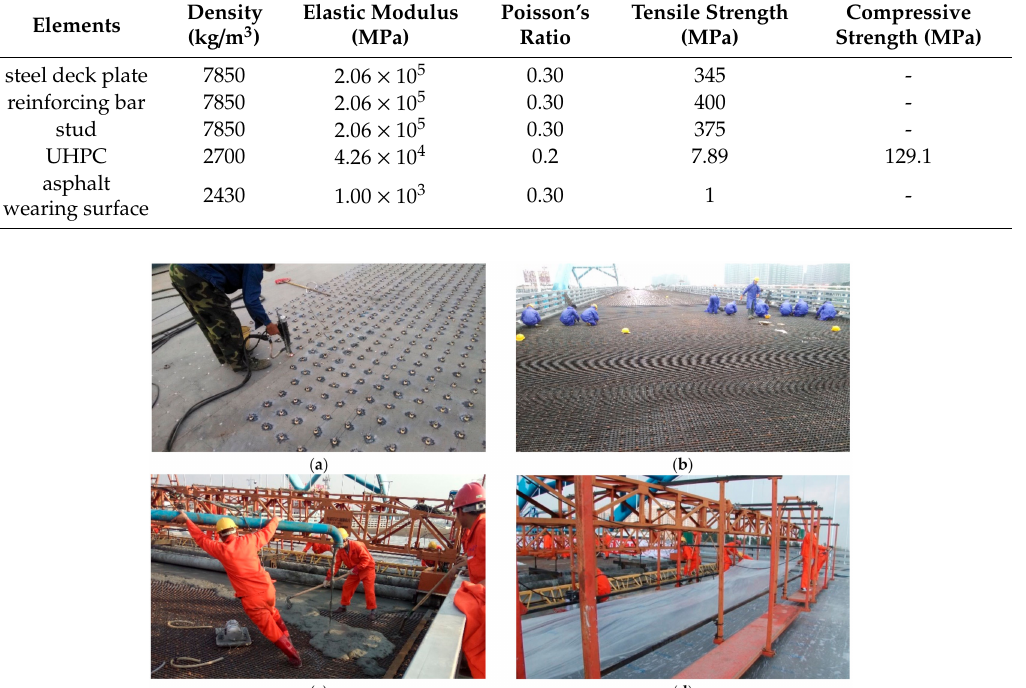
Table 1. Mechanical properties of the elements of the UHPC composite orthotropic steel deck (OSD).